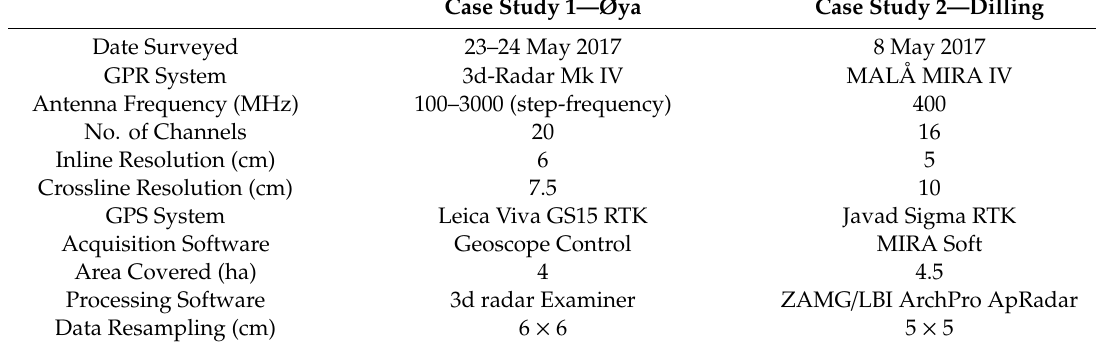
Table 1. GPR systems, software and survey parameters for the two case study areas.